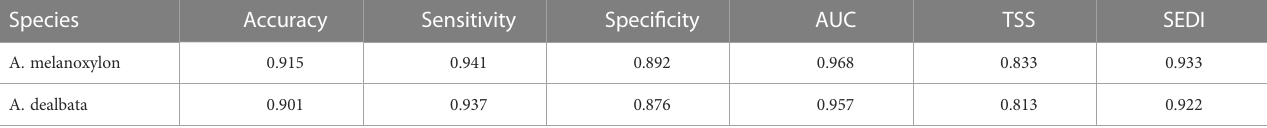
TABLE 2 Accuracy metrics for SDMs. See methods for details.